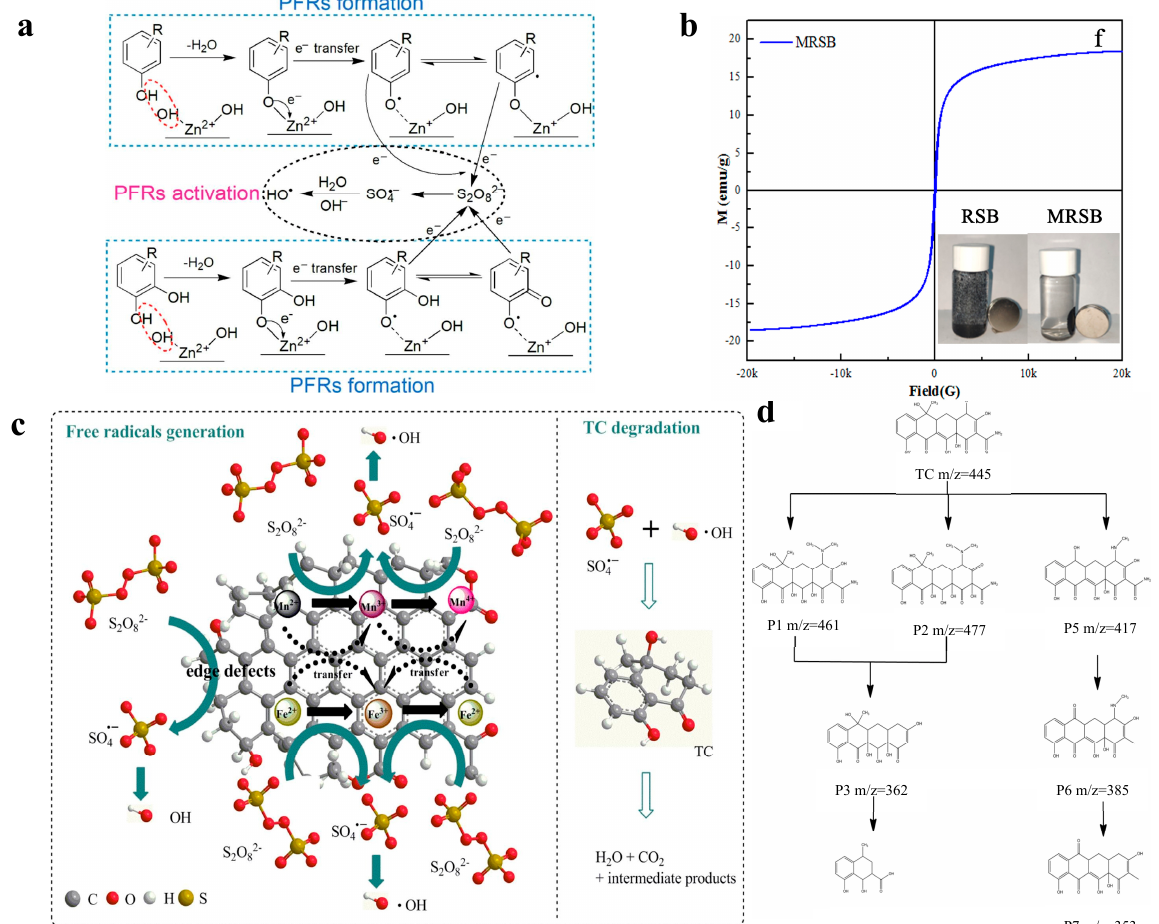
Figure 3. ( a ) Proposed pathway of persistent free radicals (PFRs) formation and persulfate (PS) activation by ZnO/biochar. Reproduced with permission from [13]. ( b ) The magnetization curve of the magnetic rape straw biochar (MRSB). Reproduced with permission from [57]. ( c ) Main catalytic mechanism of PS activation on Mn – doped magnetic biochar for tetracycline degradation. ( d ) Proposed corresponding tetracycline degradation pathways. Reproduced with permission from [59].